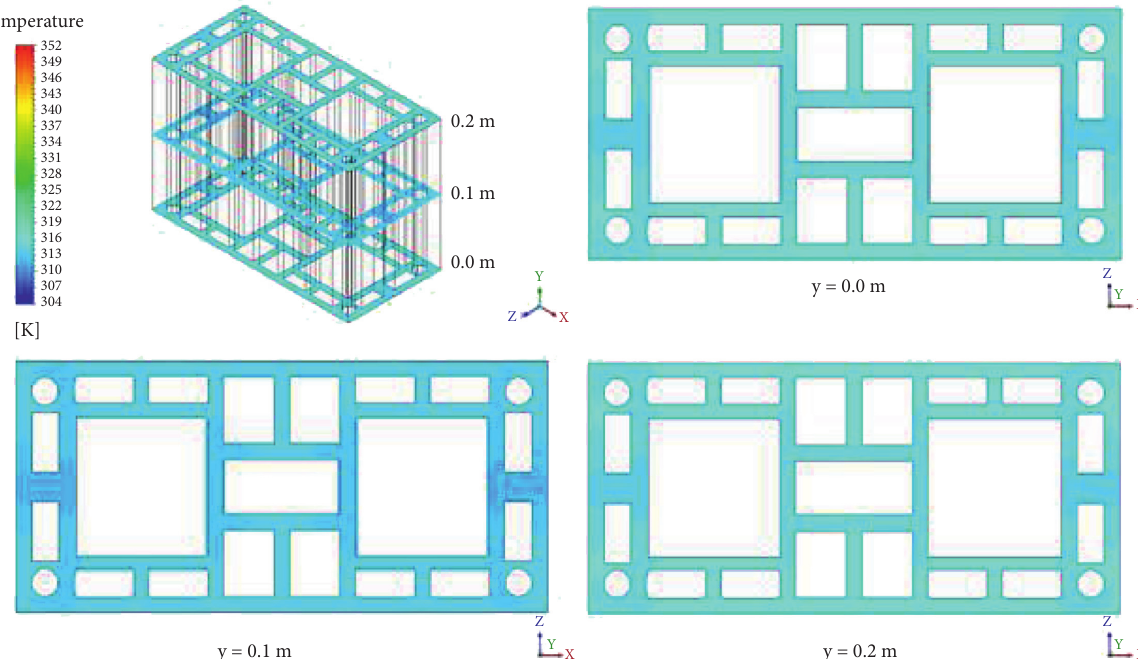
Figure 11: Temperature field inside the brick at different XZ planes, with the elapsed time of 30 minutes ( T � 80 ° C, RH �